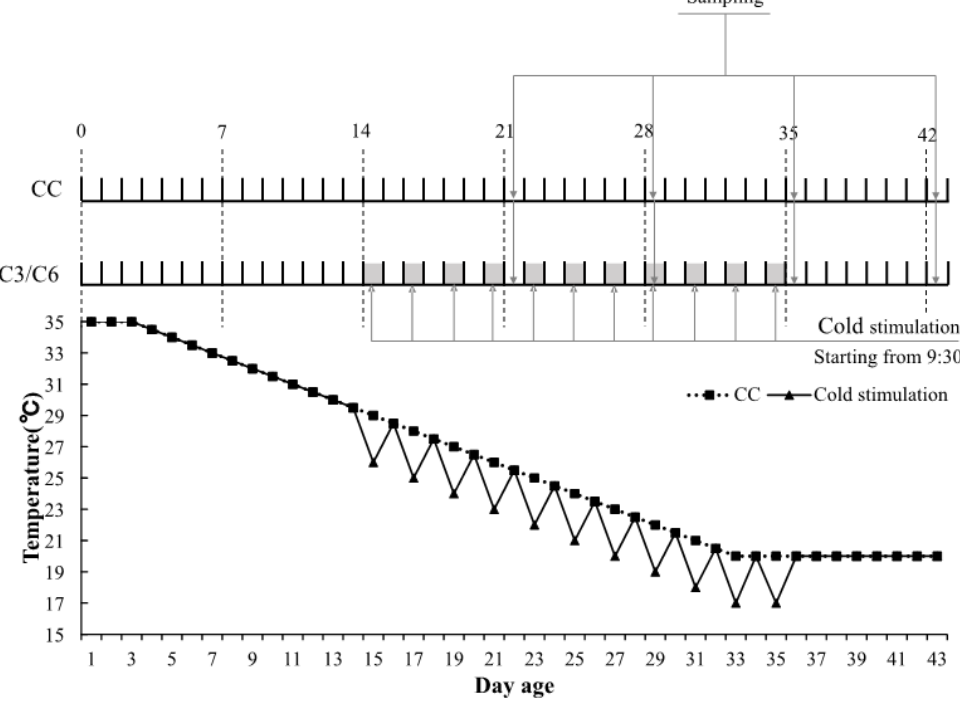
Figure 1. The temperature for experiment scheme.